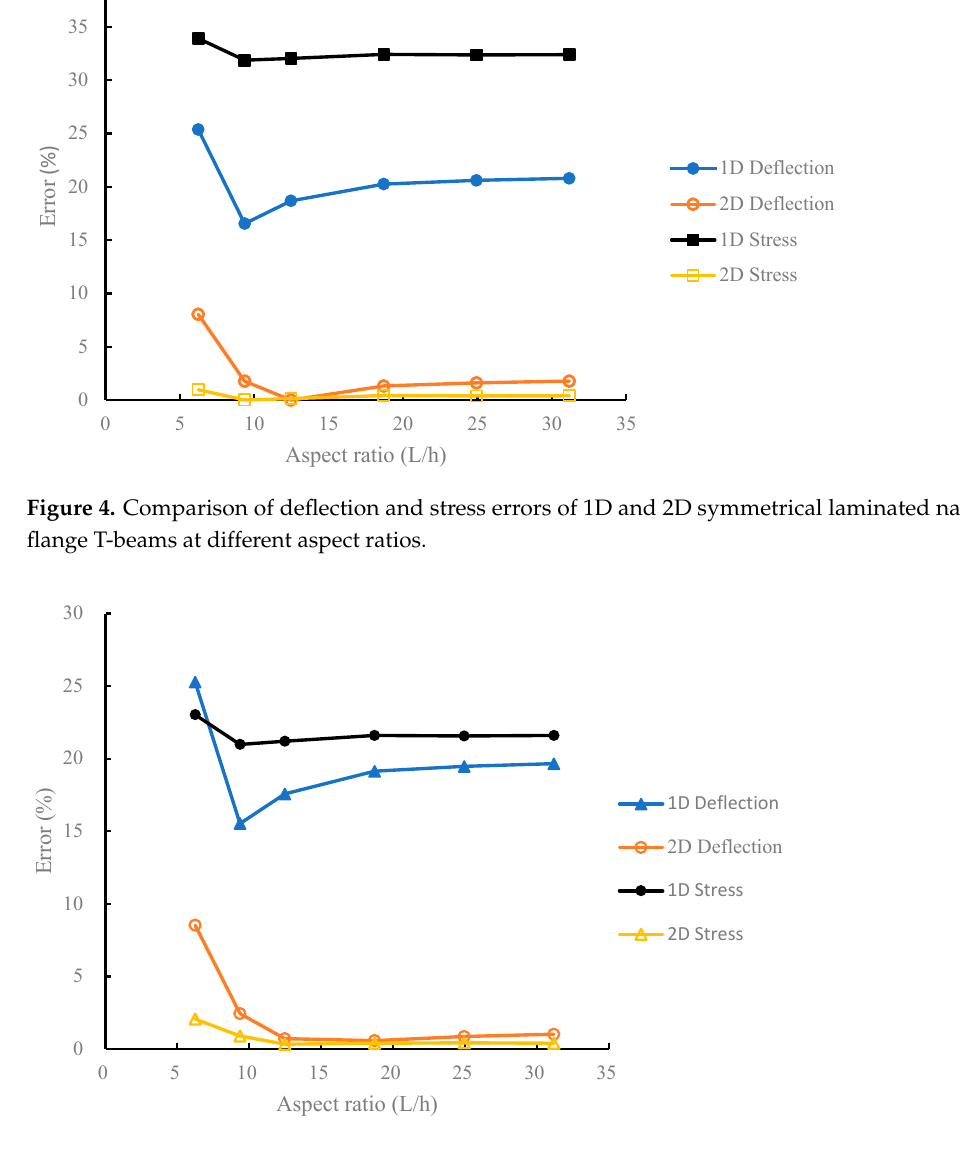
Figure 5. Comparison of deflection and stress errors of 1D and 2D non-symmetrical laminated narrow flange T-beams at different aspect ratios.